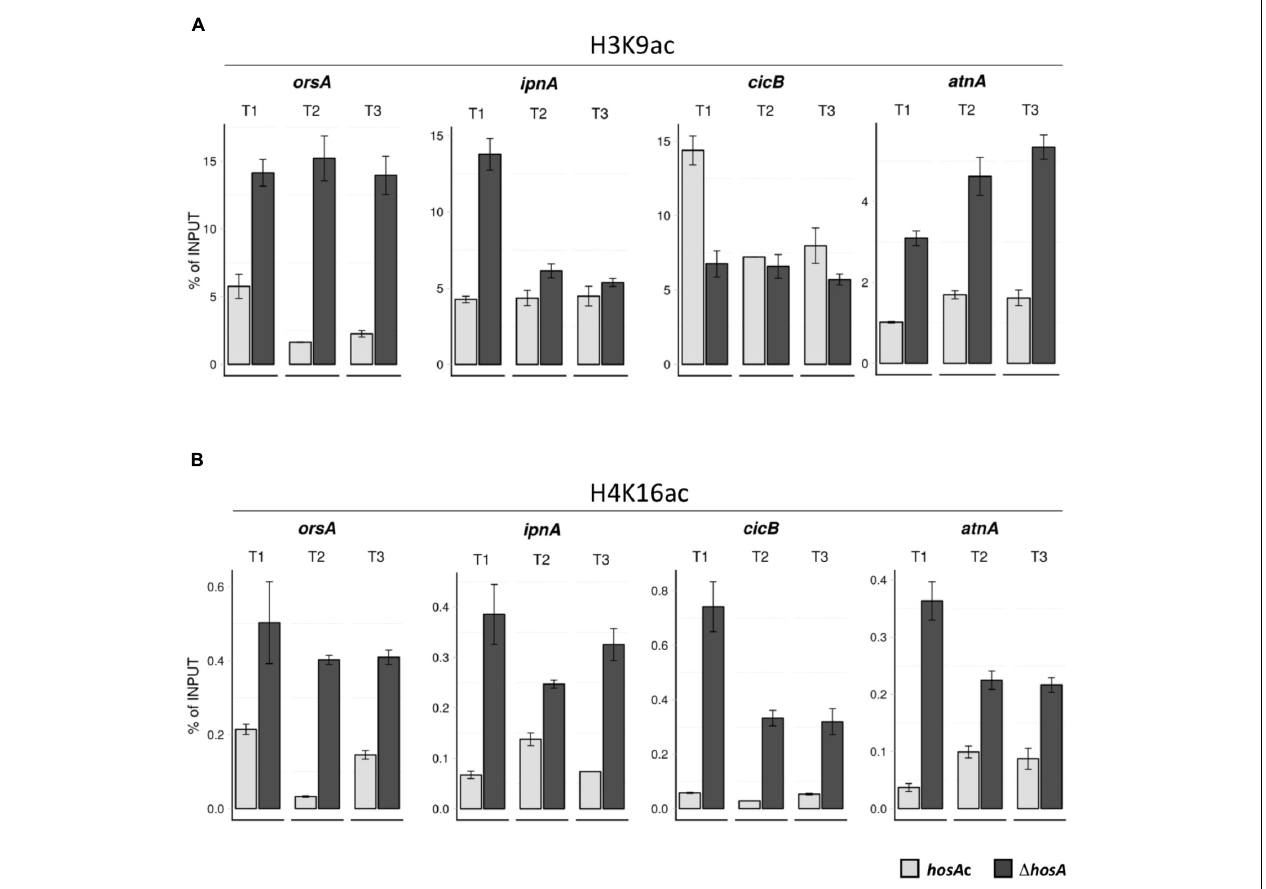
FIGURE 8 | ChIP analysis of H3K9 and H4K16 acetylation in hosA mutants and hosA -complemented strains. Bars indicate enrichment of complemented strains (light) and hosA mutants (dark) in percentage of the input-DNA used for ChIP analysis. The crosslinked protein-DNA-complex was incubated with antibodies against H3K9ac (A) and H4K16ac (B) , respectively. For each of the genes orsA , ipnA , cicB , and atnA , qPCR was performed using primer-sets specific for three targets (T1, T2, T3) within the 5 (cid:48) regions of the corresponding coding sequences. Error bars represent standard deviation calculated from triplets of each